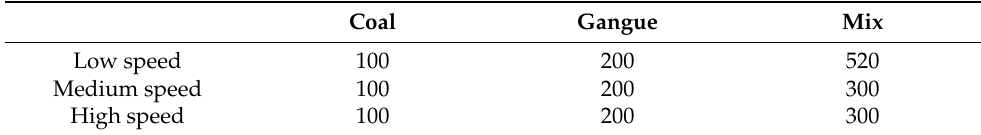
Table 1. Distribution of